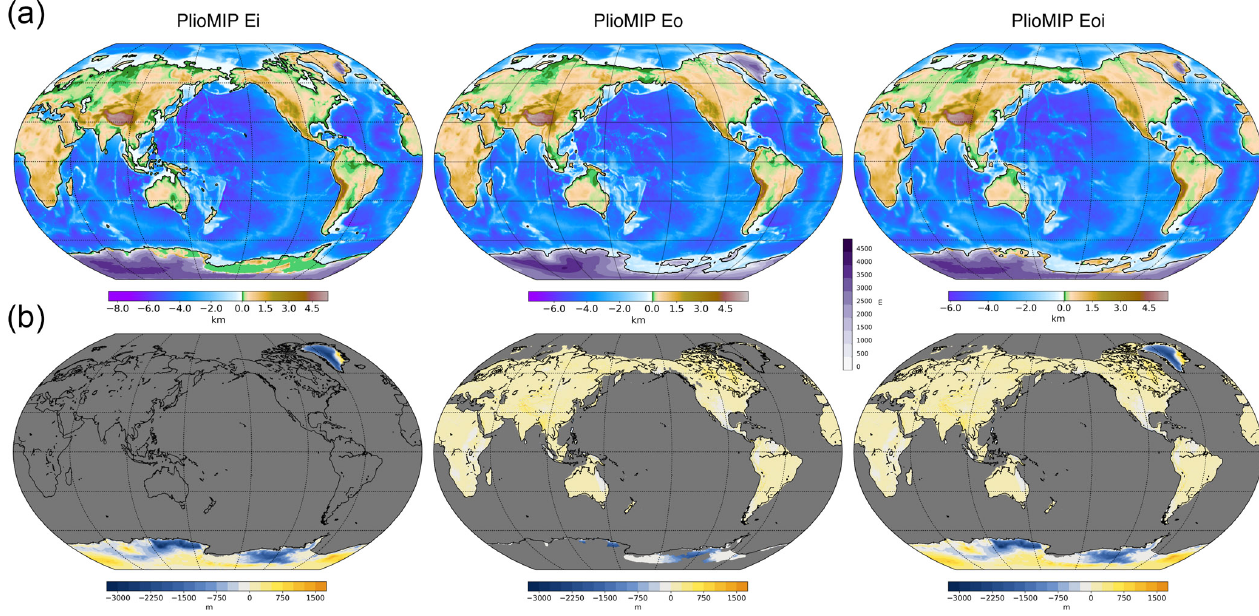
Figure 1. The topography for the Ei, Eo, and Eoi experiment configurations (a) and the orographic anomaly of those configurations from PlioMIP2 modern (b) . The land-based ice sheets in the top row are displayed on the purple-colored scale that is shown